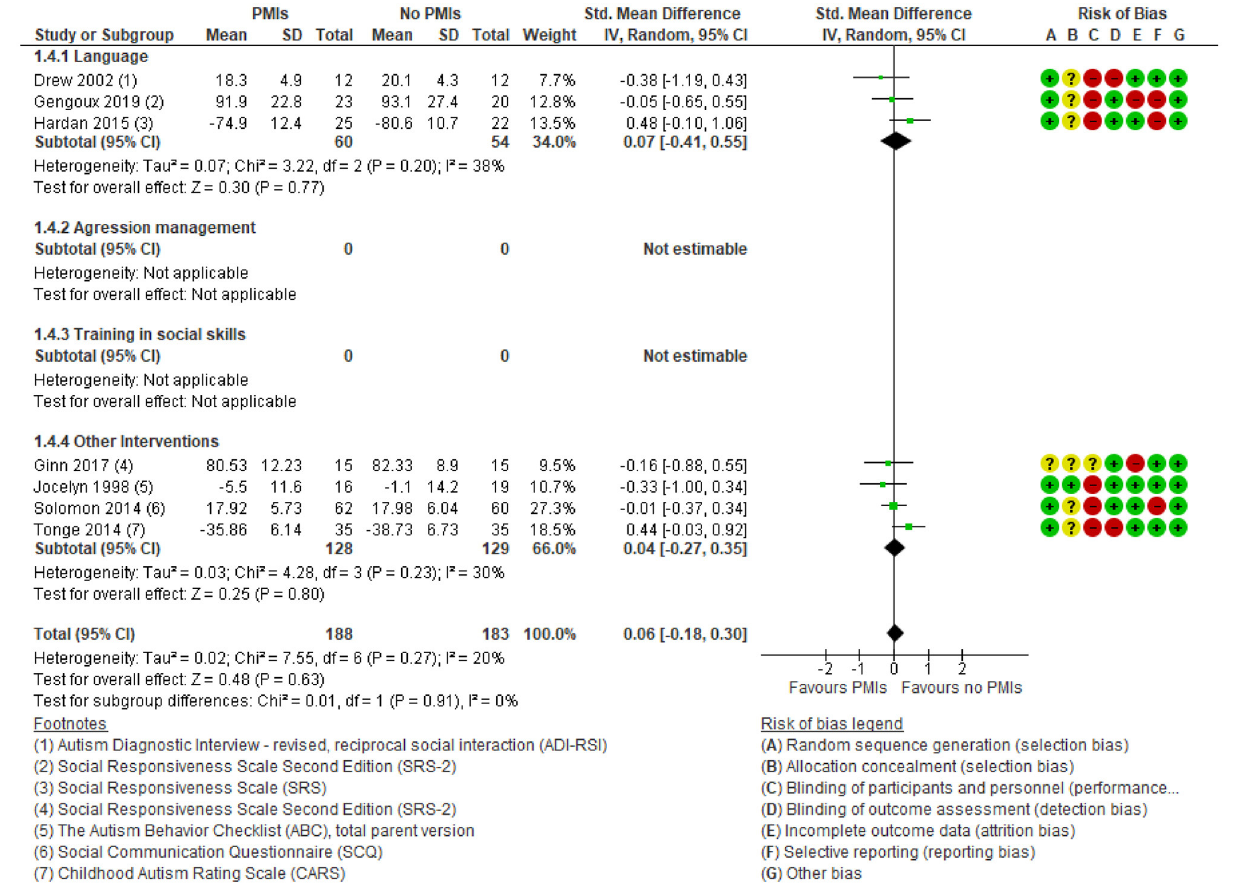
(95% CI: − 0.74, − 0.36)] ( Figure 9 ). None of the